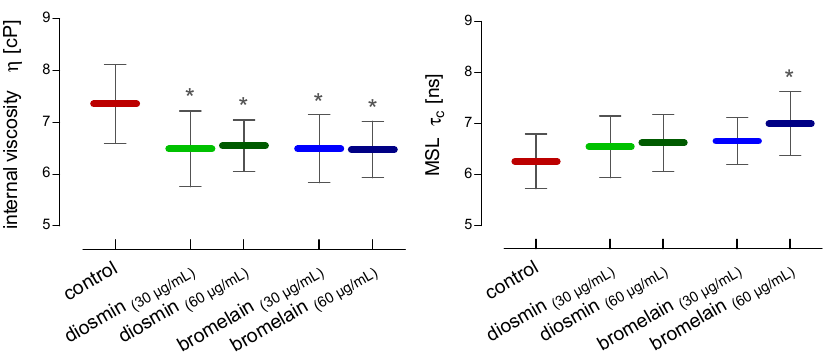
Figure 4. Alterations in internal viscosity and maleimide (MSL) spin label mobility in RBCs after 24 h of incubation with diosmin or bromelain. The data were expressed as mean ± standard deviation, n = 12. Statistical significance: * p < 0.05 vs. control.